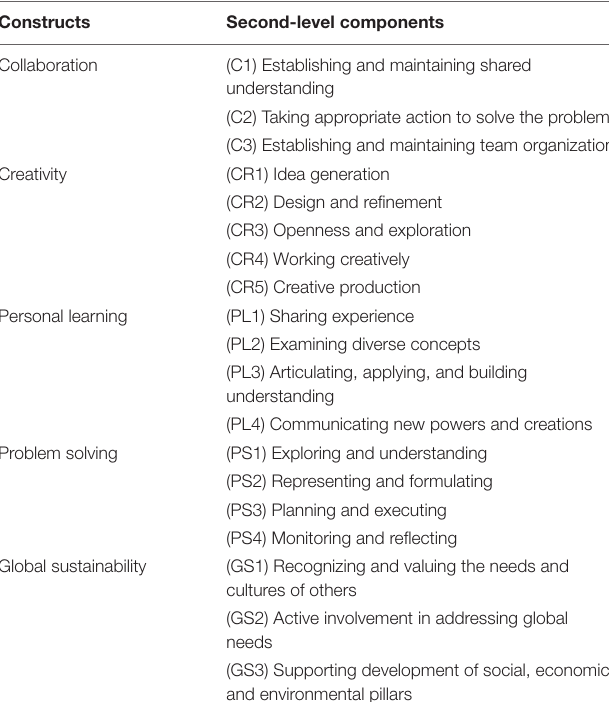
TABLE 2 | Second-level components that define the metadata for unobtrusive observations of team-based learning attributes in Balance of the